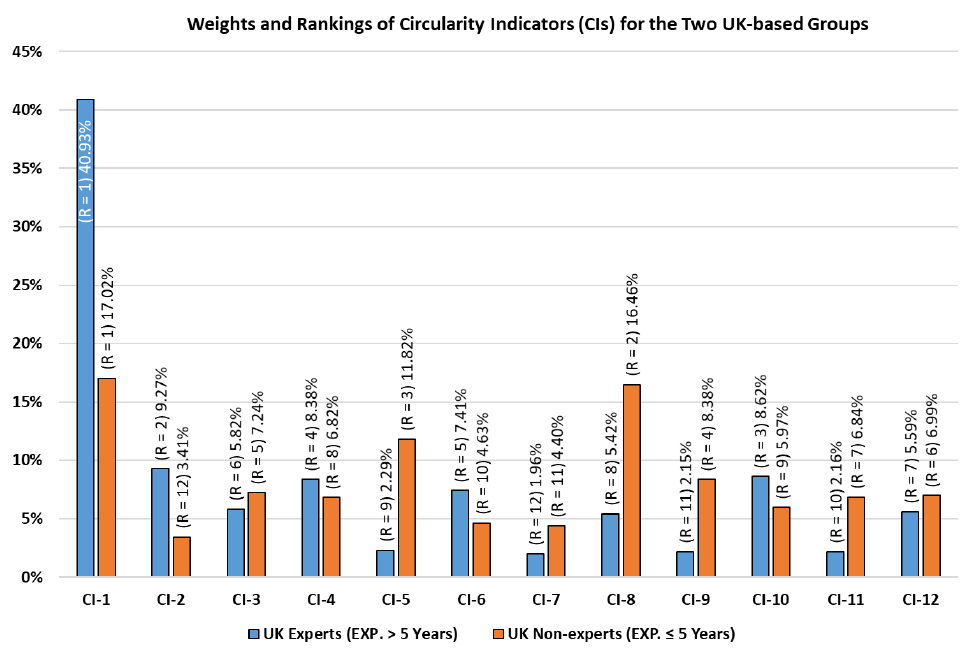
Figure 7. Weights/rankings for circularity indicators (CIs) for the UK-based groups. Table 8. Local/global weights, and global rankings for CIs for the two UK-based groups.